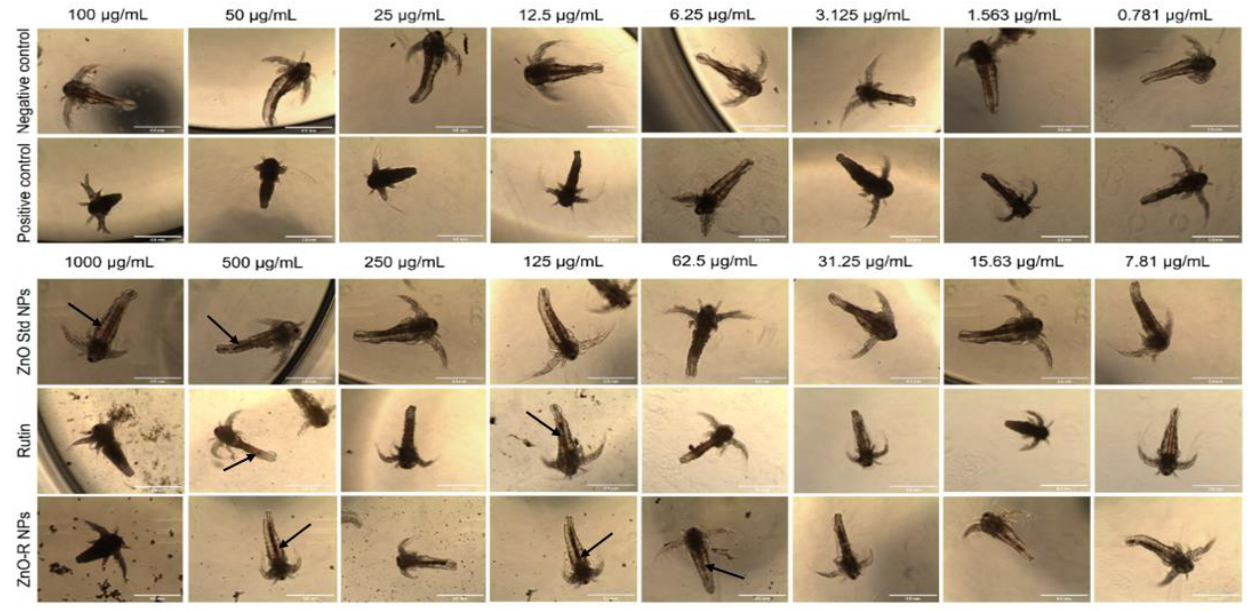
Figure 10. Morphology of the treated and untreated Artemia nauplii after treatment with the prepared samples.